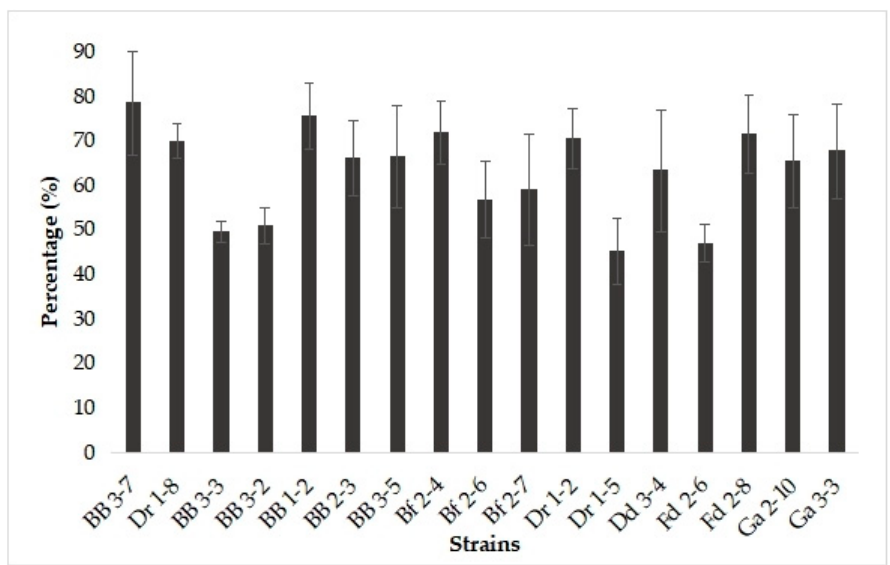
Figure 2. Antioxidant activities (%) of the yeast isolates evaluated by DPPH reduction.